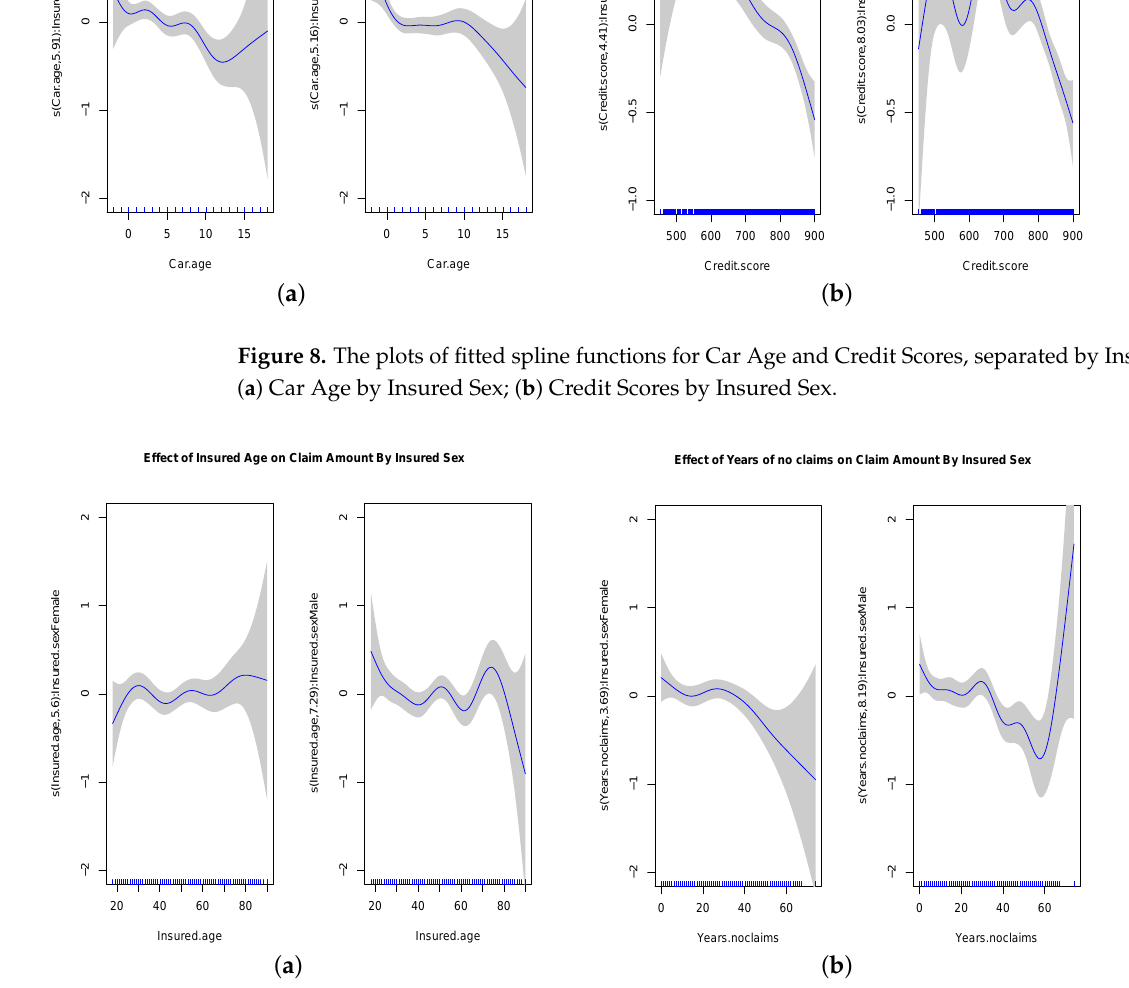
Figure 9. The plots of fitted spline functions for Insured Age and Years of no Claims, separated by Insured Sex. ( a ) Insured Age by Insured Sex; ( b ) Year of no Claims by Insured